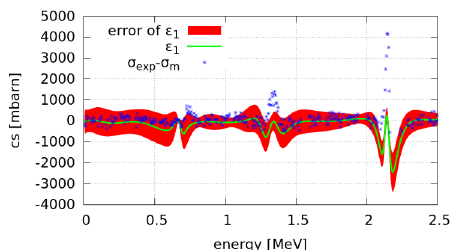
Figure 4. Comparison of the di ff erence σ exp − σ M with the calculated model error ∈ 1 .